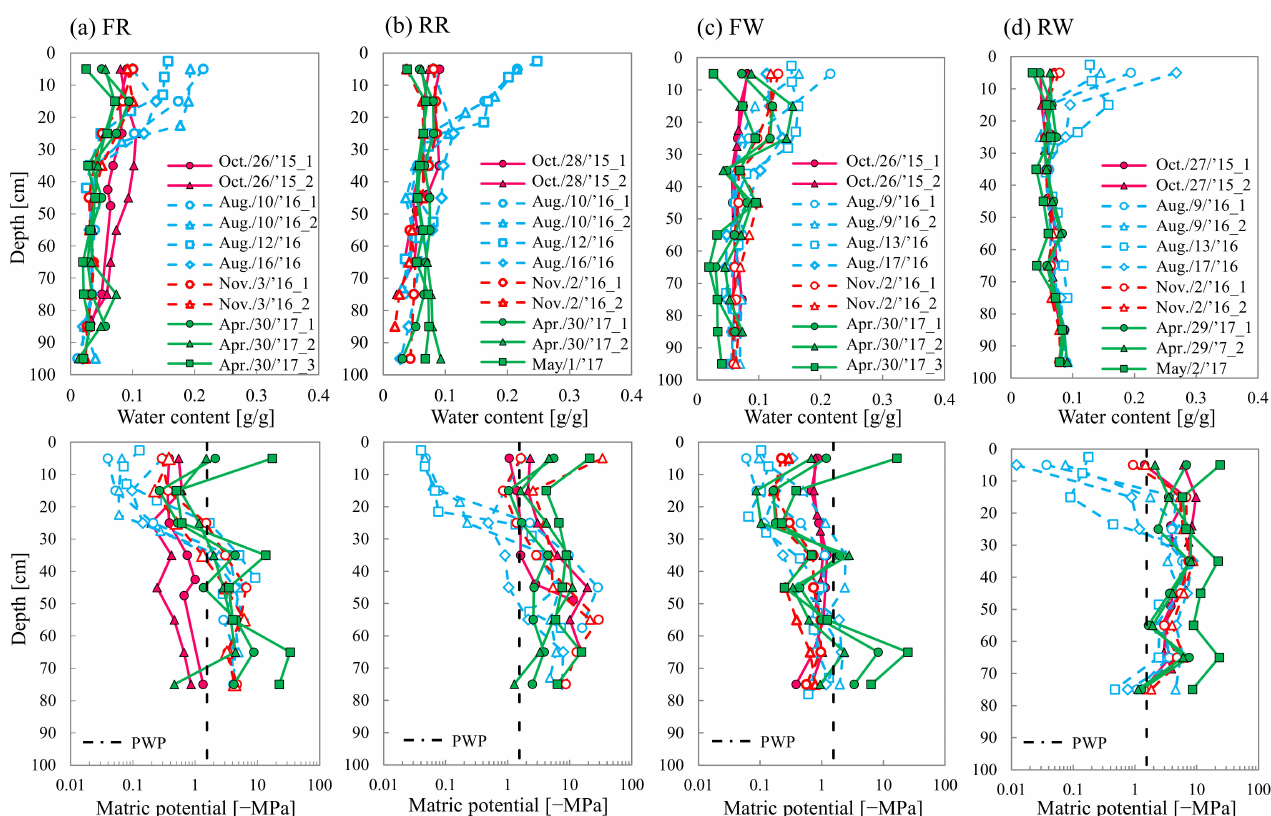
Figure 6. Temporal changes in soil moisture with time. The figures above show the vertical distributions of water content; the others below show that of water potential at ( a ) FR, ( b ) RR, ( c ) FW, and ( d ) RW in 2015 and 2016. The dashed line represents the permanent wilting point (PWP; − 1.55 MPa). FR is the rapeseed field, FW is the wheat field, RR is the rangeland adjacent to FR, and RW is the rangeland adjacent to FW. According to the weather station located 11–13 km southeast of the study sites, no rain and snow was observed in the weeks preceding 2 November 2016 and 29 April 2017 and rain or snow was observed on 25 October 2015 (=3.5 mm) and August 9 and 10 (=25 and 39 mm, respectively), 2016. We confirmed snowing and snow pile-up on-site on 25 October 2015 and heavy rainfall on 10 August